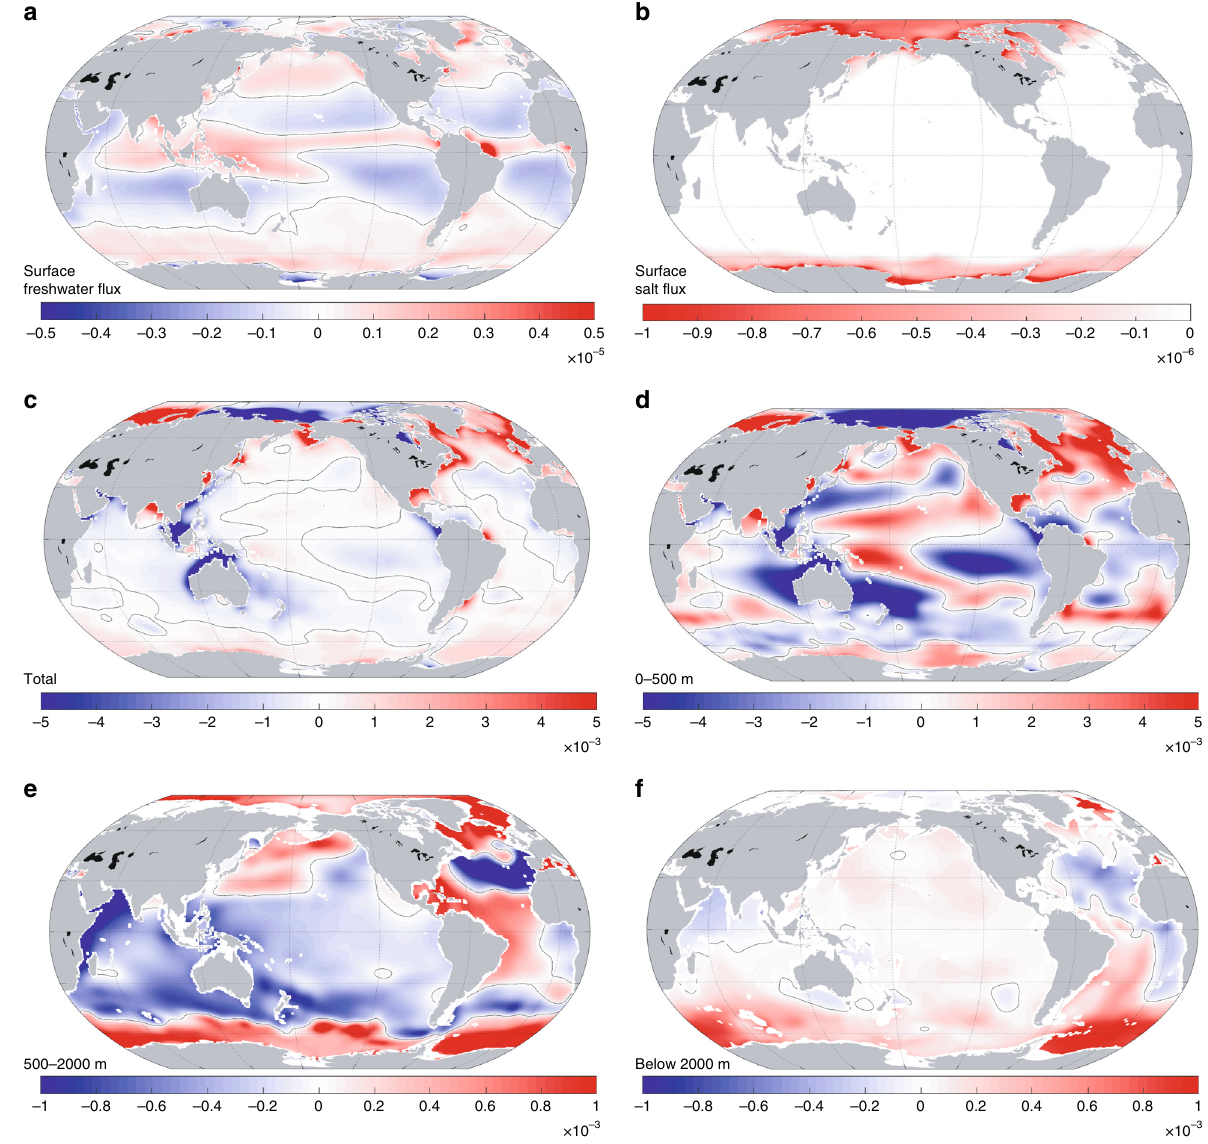
Fig. 3 Surface fl uxes and trends of salinity in sampled layers. a 22-year mean of the ocean surface freshwater fl ux (converted to psu m s − 1 ). b Net surface salt fl ux into the ocean due to sea ice formation processes (psu m s − 1 ). In a and b , positive values stand for net downward (upward) freshwater (salt) transport. c – f 22-year trends (psu year − 1 ) of ocean salinity averaged over the whole water column ( c ) and three different layers ( d – f ). Note that the scale varies in different